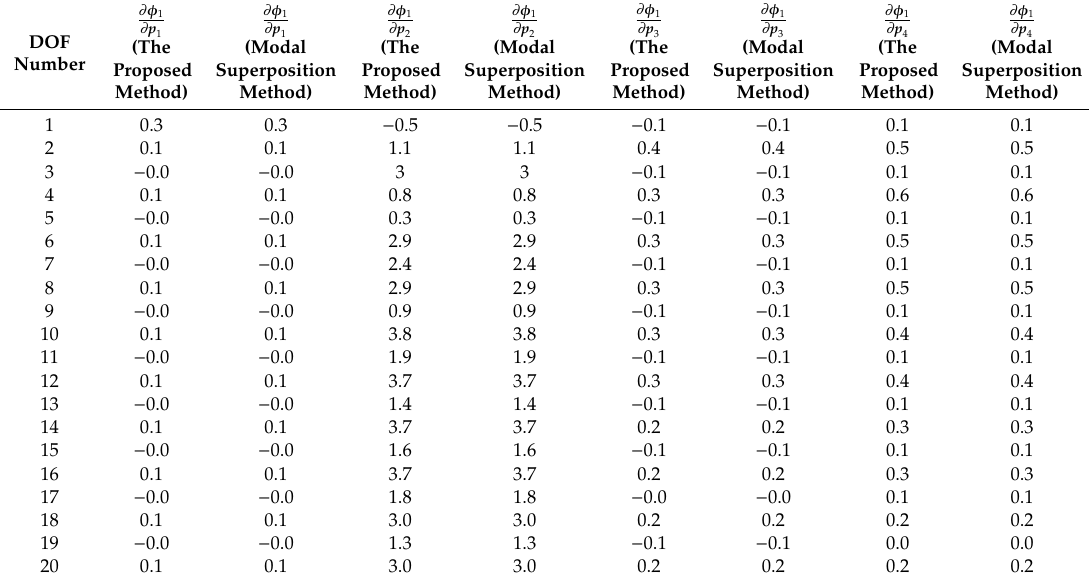
Figure 1. A truss structure. Table 1. Comparison of the calculation results for the first eigenvector sensitivity (×10 − 3 ).